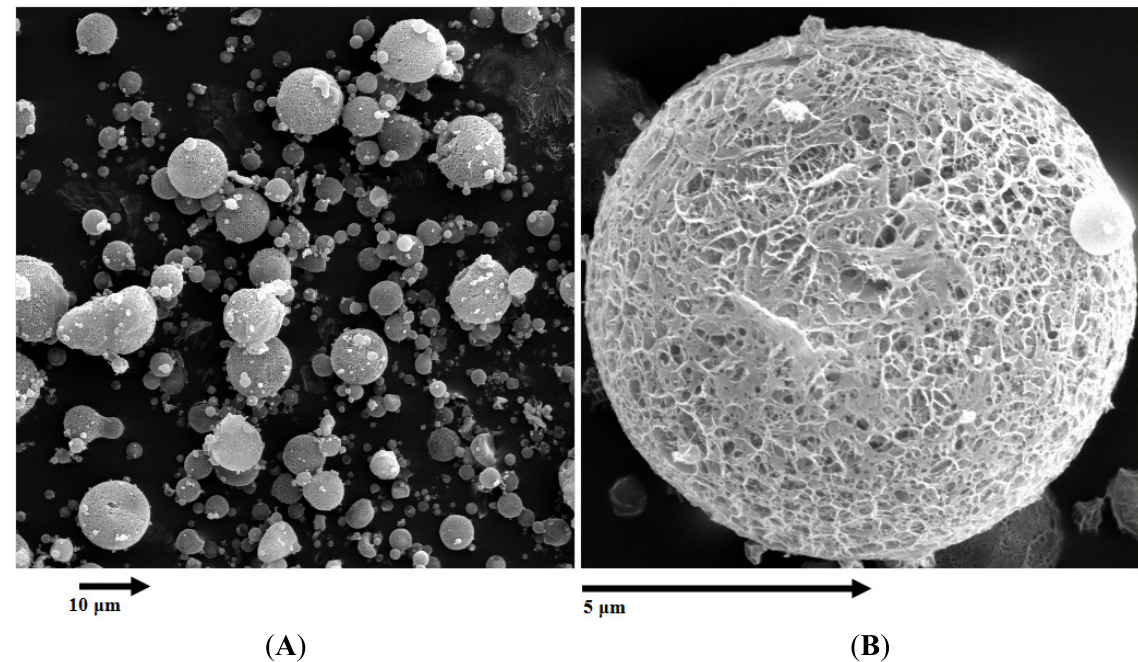
Figure 2. Transmission electron microscope photograph of DTX-loaded